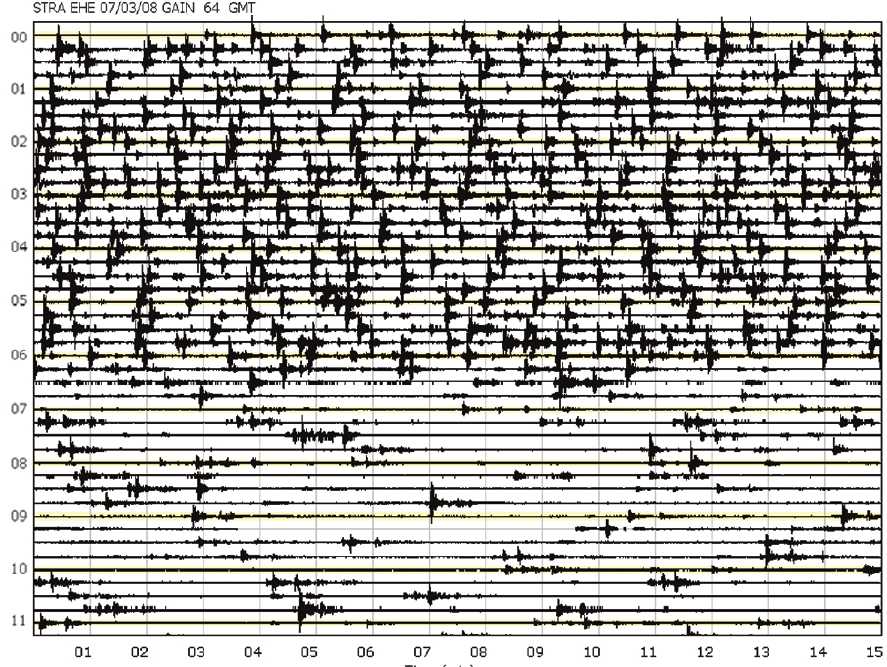
Fig. 14. The end of the swarm of more than 2000 hybrid events recorded during the March 6-8, 2007, period by the STRA station (east-west